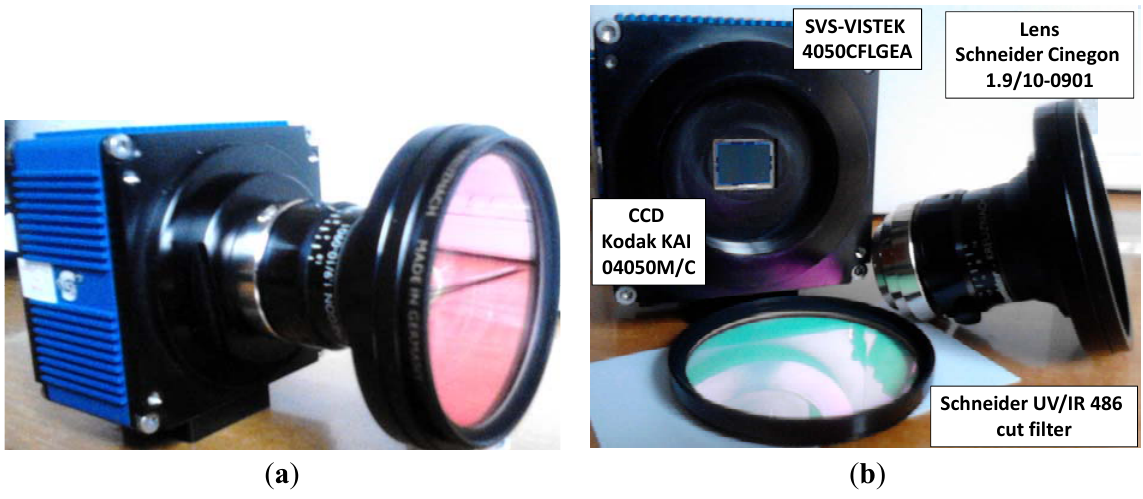
Figure 1. CCD sensor, lens and UV/IR cut filter: ( a ) integrated. ( b )